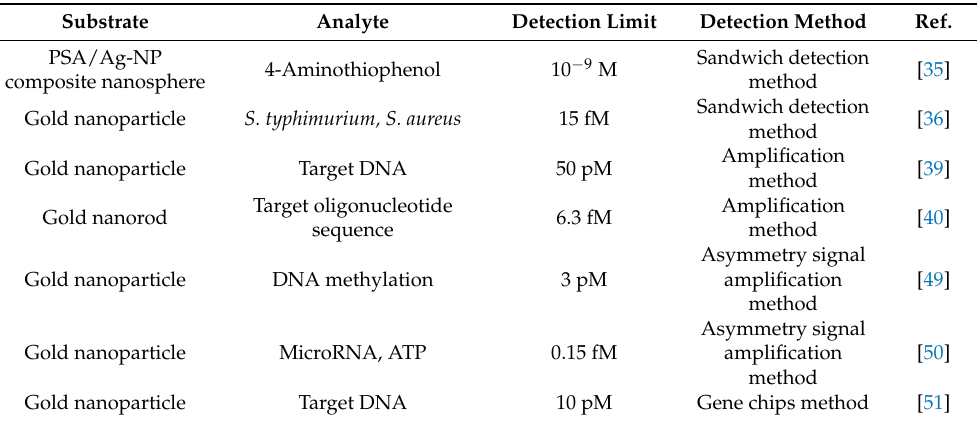
Table 1. SERS for DNA